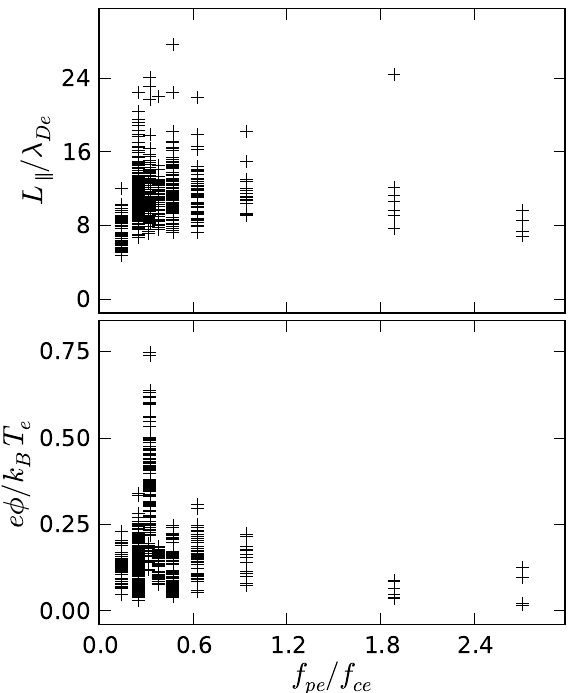
Fig. 8. Parallel half-width and amplitude as a function of f pe /f ce in the various experiments.